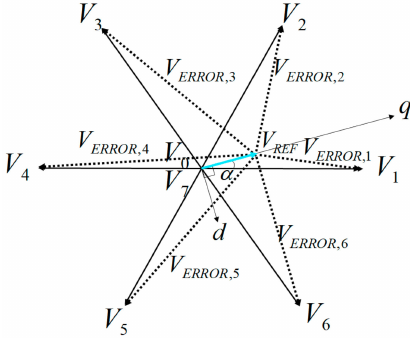
Figure 3. Error voltage vectors in the